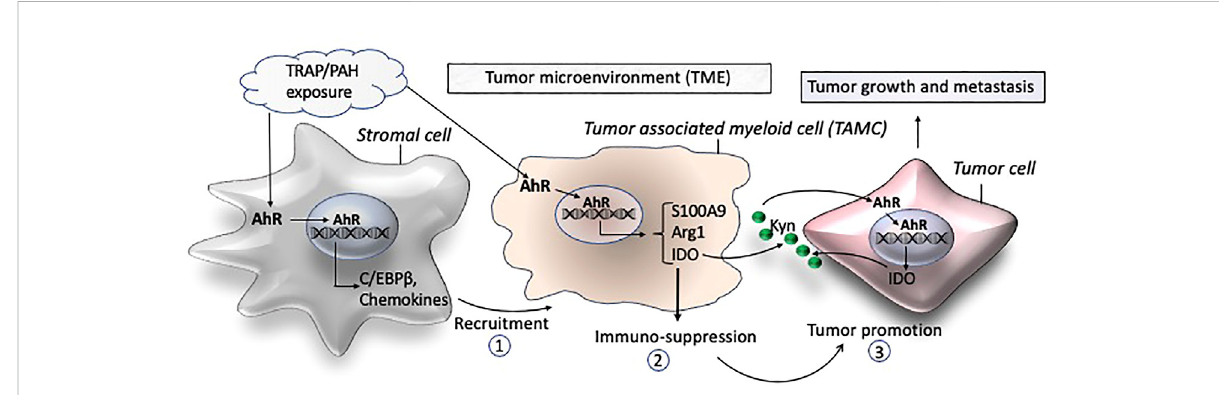
FIGURE 1 Schematicofproposedmechanismsbywhichtraf fi c-associatedairpollution(TRAP)activatesAhRtoinducetheaccumulationofTAMCs(1)and expression of immune suppressive factors (2) leading to a tumor promoting microenvironment (3) and growth and metastasis of breast